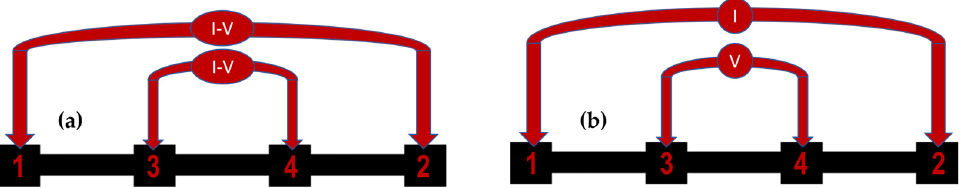
Figure 3. Measurement setup electrical characterisation: ( a ) two-point configuration; ( b ) four-point configuration.